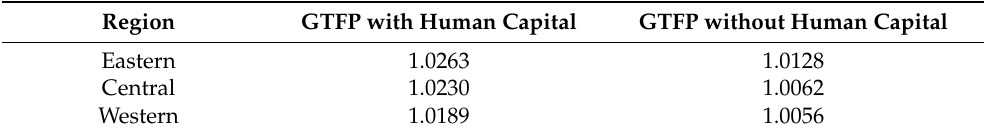
Table 5. Comparison of regional GTFP.